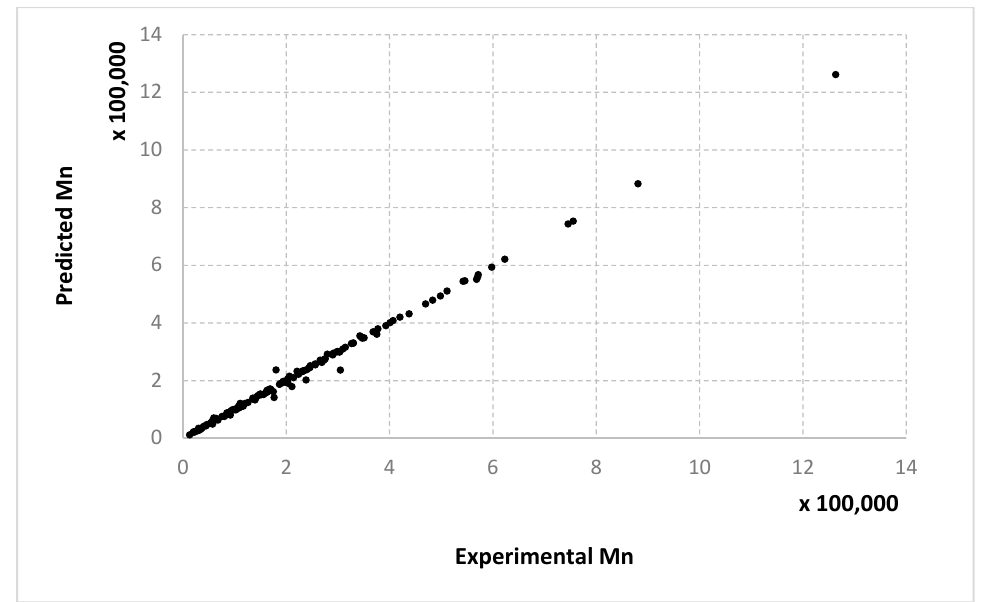
Figure 10. Predicted numerical average molecular weight with the RADIAN algorithm versus experimental data, setting 2, with data split into 67% for training and 33% for testing.